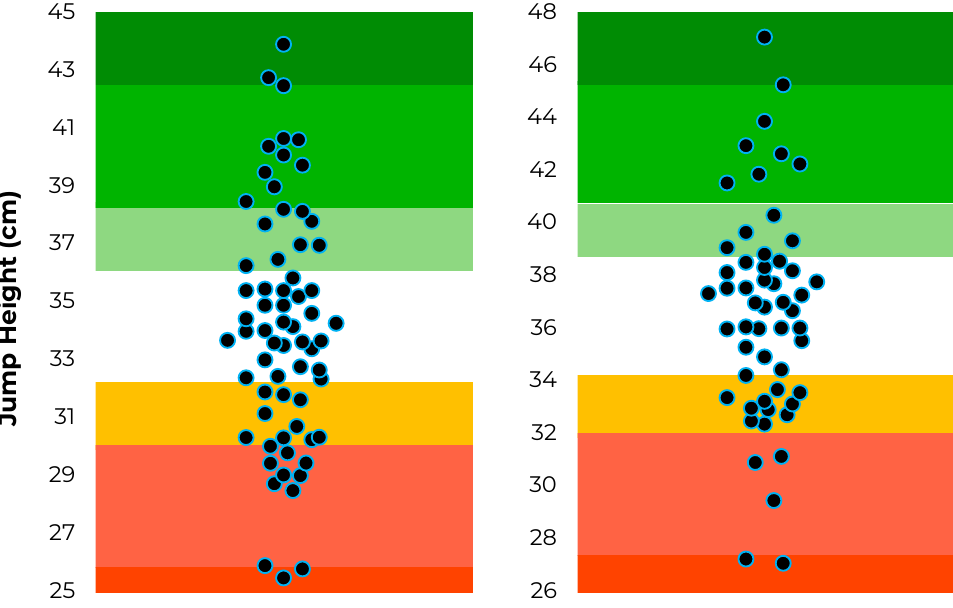
Figure 2. Distribution of jump height scores (represented by the individual dots) and corresponding traffic light system based on T-score thresholds for rugby league forwards ( left ) and backs ( right ). The forwards were taller than the backs (1.84 ± 0.06 m vs. 1.81 ± 0.06 m, p = 0.005) with a moderate effect size ( g = 0.55 [CI 95 range = 0.15–0.95]). The forwards were also heavier than the backs (102 ± 9 kg vs. 90 ± 9 kg, p < 0.001) with a large effect size ( g = 1.44 [CI 95 range = 0.98–1.89]). The mean jump height was higher for the backs (36.4 ± 4.5 cm vs. 34.1 ± 4.2 cm, p = 0.005) with a moderate effect size ( g = 0.50 [CI 95 range = 0.13–0.87]). The mean modified reactive strength index was also higher for the backs (0.49 ± 0.08 vs. 0.44 ± 0.08, p = 0.003) with a moderate effect size ( g = 0.55 [CI 95 range = 0.18–0.93]). Contrastingly, the mean jump momentum was higher for the forwards (262.6 ± 25.5 kg · m/s vs. 240.3 ± 27.8 kg · m/s, p < 0.001) with a large effect size ( g = 0.80 [CI 95 range =